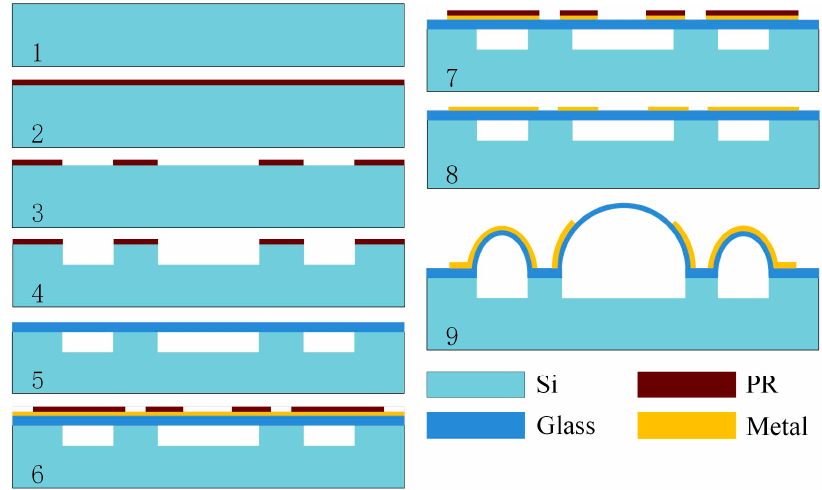
Figure 6. Detailed fabrication of making annular electrodes and the hemispheric shell. 1: Prepare the wafer; 2: Spin the photoresist; 3: Photolithography; 4: DRIE; 5: Clean wafer and bond glass wafer; 6: Sputter metal and photolithography; 7: Etch metal; 8: Clean the wafer; 9: Anneal the wafer to form annular electrodes and hemispheric shell.